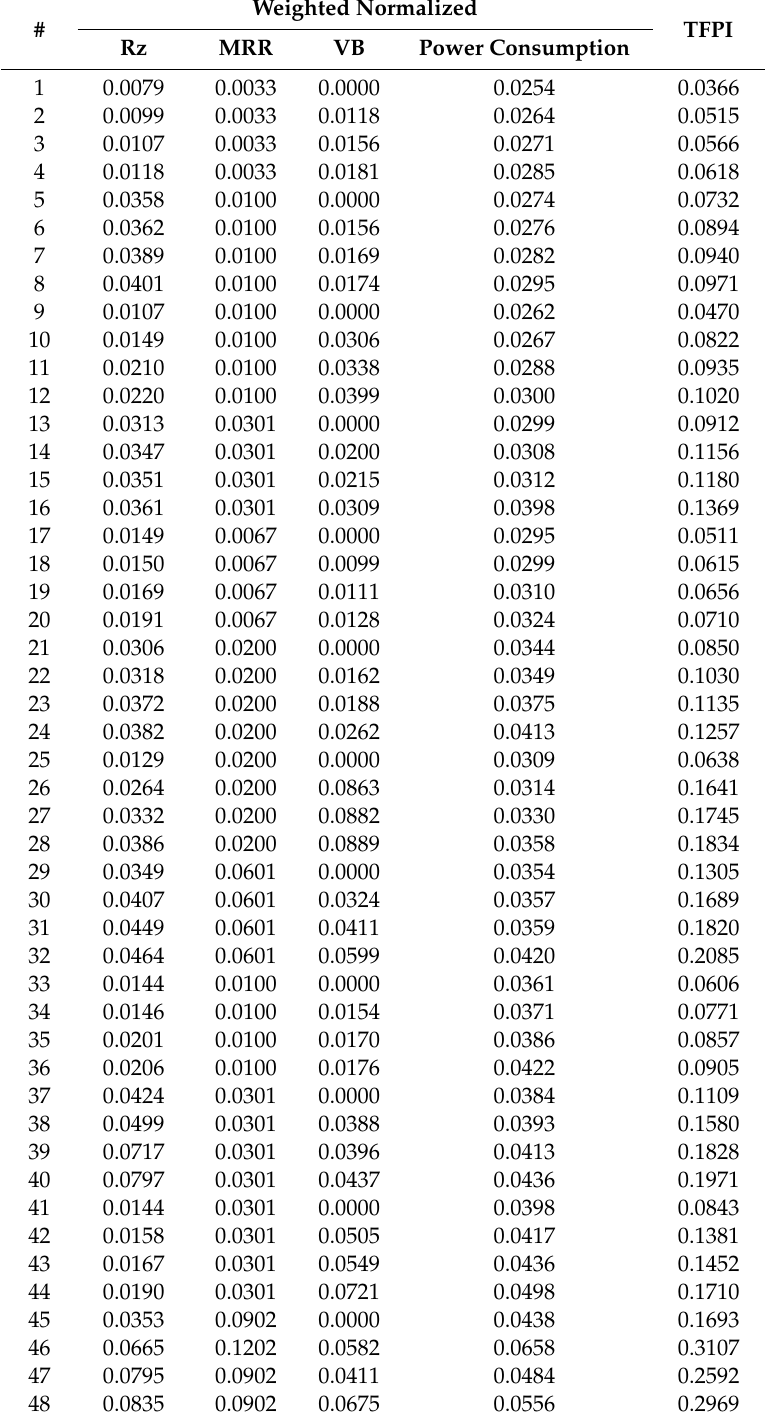
Table 4. TOPSIS normalized results and fuzzy-based performance